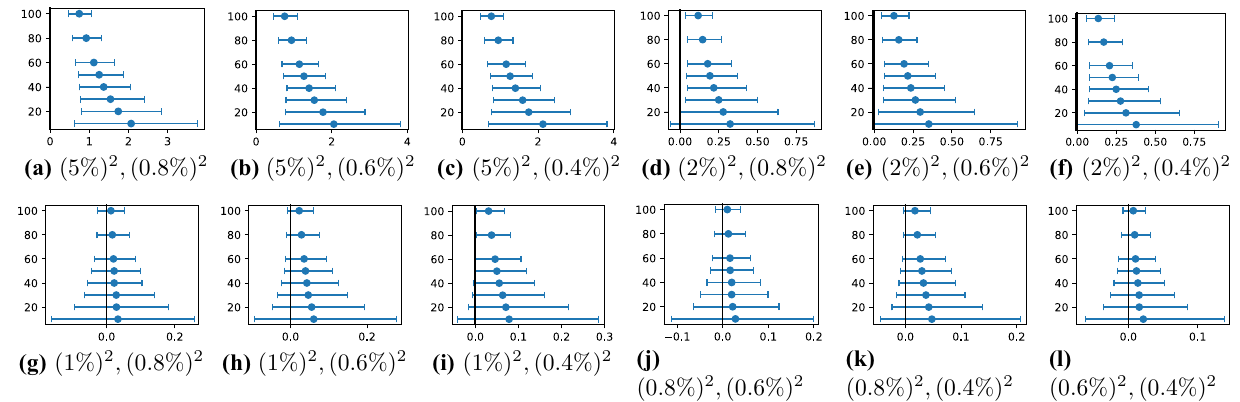
Fig. 7 The value gained by having some experimentation and meas- urement (E&M) capabilities ( x -axes, in percent) under different capacity M ( y -axes) in the case study on 184 marketing experiments reported by Johnson et al. [12] (see Sect. 7.2). In each plot, the dot represents the mean, and the error bar represents the 5th–95th per-